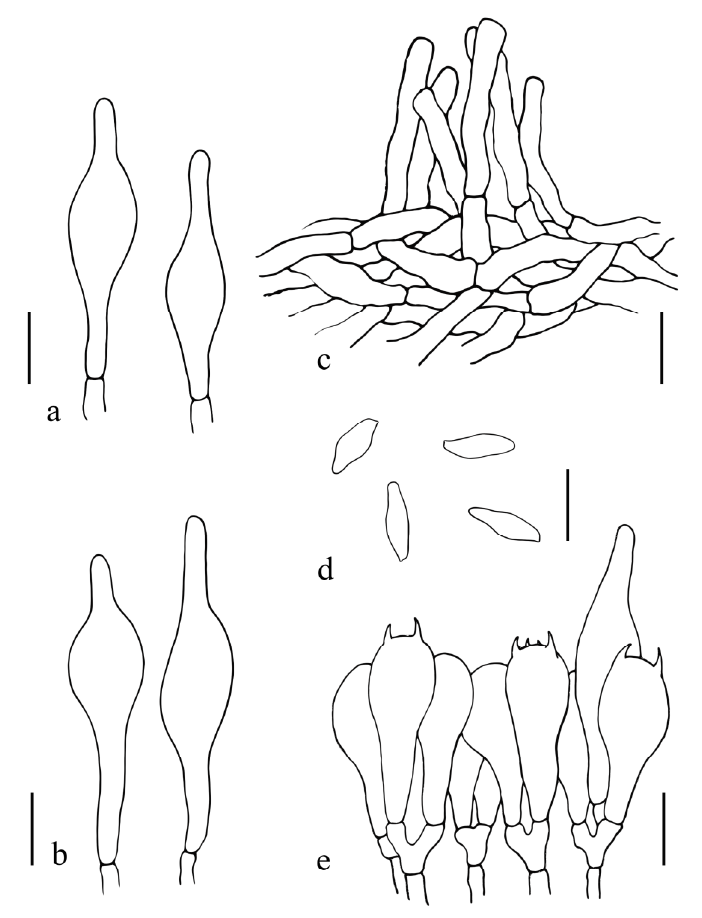
Figure 8. Butyriboletus subregius . ( a ) Pleurocystidia; ( b ) Cheilocystidia; ( c ) Pileipellis; ( d ) Basidiospores. ( e ) Pleurocystidia and basidia. Scale bars: 10 μm. Basidiomata middle to large. Pileus 7.0–13.0 cm in diameter, hemispherical or broadly hemispherical at maturity, with distinctly appendiculate margin initially, sur- face dry, covered with weak or distinct tomentum, pastel pink (11A4–5), context yellow- ish green (30A6), turning blue when cut. Hymenophore weakly decurrent, covered with a layer of whitish mycelium (1A1) when young, surface yellowish green (29A6), bluing when bruised, pores angular to nearly round, ca. 4–5/mm; tubes concolorous with hyme- nophore surface, about 1.1 cm long, turning blue when cut. Stipe 11.0–14.5 × 4.4–5.0 cm, subcylindrical or enlarged downwards, yellowish green (29A6) at maturity, covered with pastel red stains when young, upper 2/3 portion covered with yellowish green (29A6) reticulation, staining blue when bruised, context yellowish green (30A6), chang- ing weakly to blue when cut.